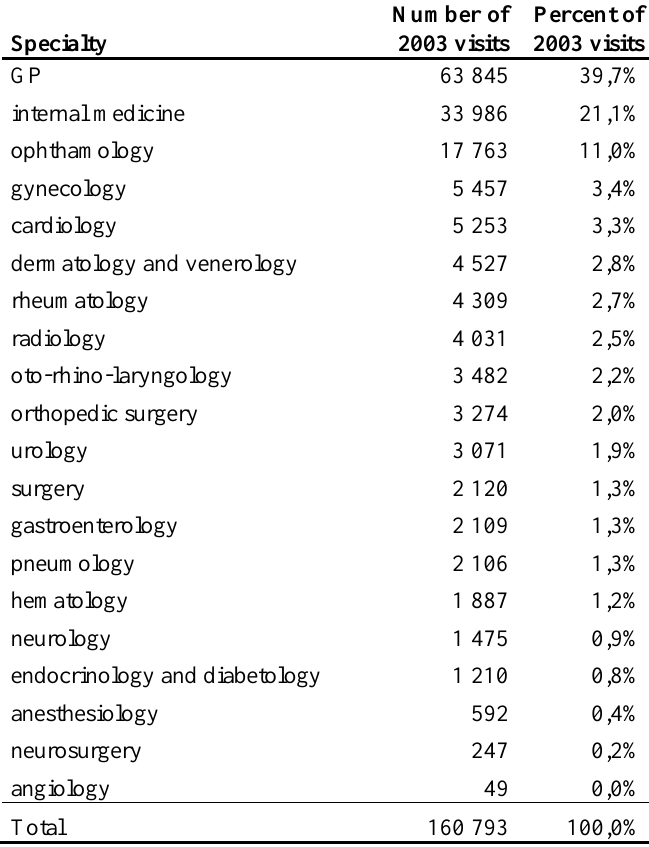
Distribution of 2003 ambulatory visits by specialty of CSS enrollees who had any 2003 cardiovascular drug prescriptions Number Specialty